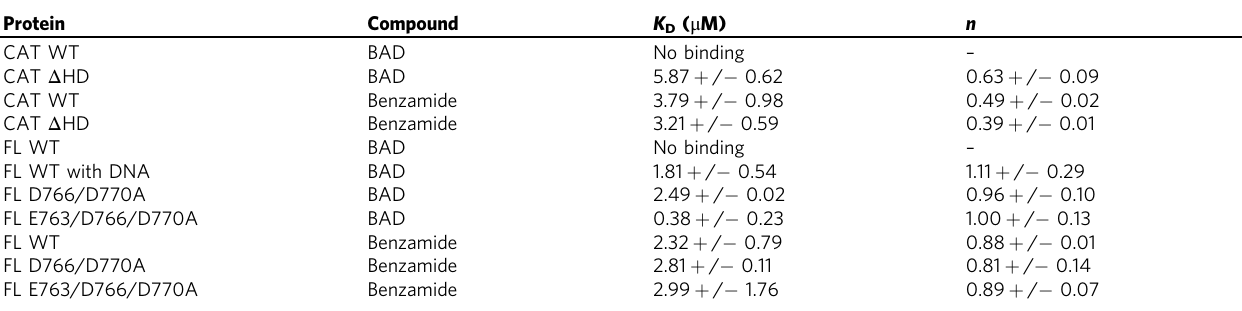
The K D and stoichiometry ( n ) values were obtained by averaging the results of two or three independent ITC experiments. The reported errors are the calculated standard deviations (representing the range of values for experiments repeated two